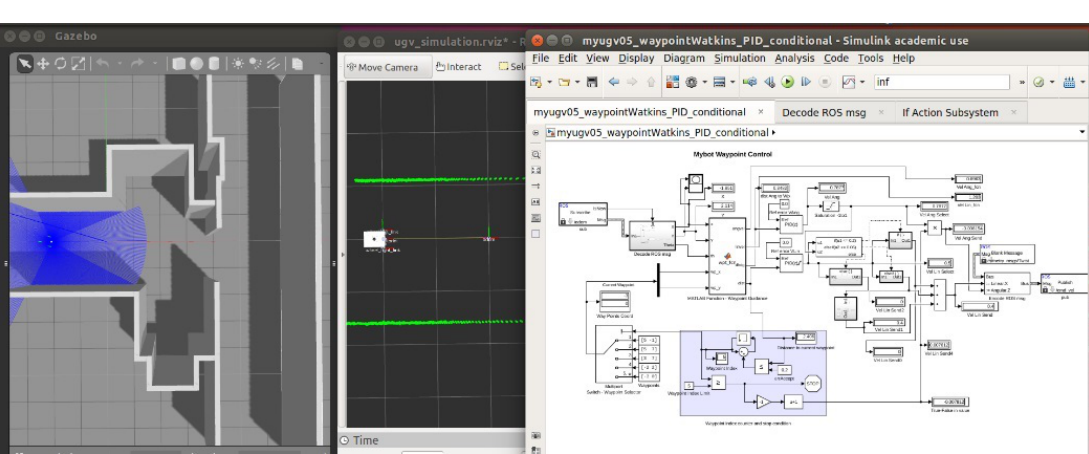
Figure 6. Wheeled mobile robot in Gazebo–ROS–Waypoints Navigation activity.